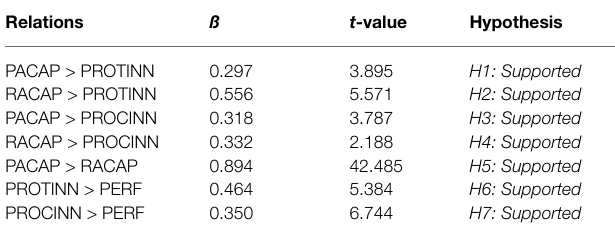
TABLE 6 | Structural